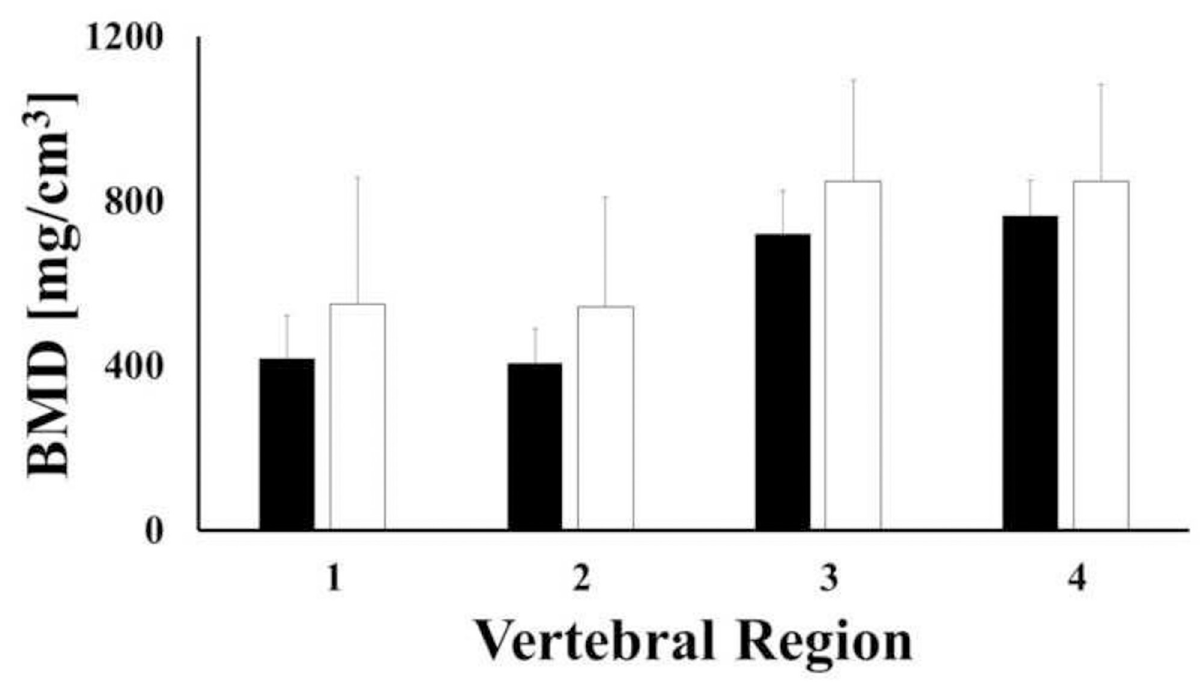
Fig 5. Mean values of bone mineral density across regions of C1 for female (white) and male (black) samples. Bars indicate one standard deviation.